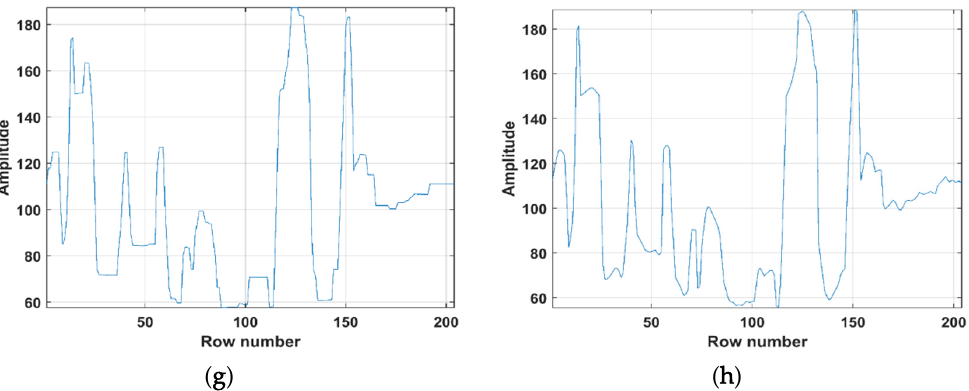
Figure 7. Comparison of drawing charts. (a–h) are the drawing charts of original “Store” image, degraded “Store” image with Gaussian blur (G, 5, 5, 7) and Gaussian noise standard deviation of 5, deblurring results of ATV, ITV, ATpV, FTV4Lp, Hybrid TV, and HTV-Lp methods, respectively.